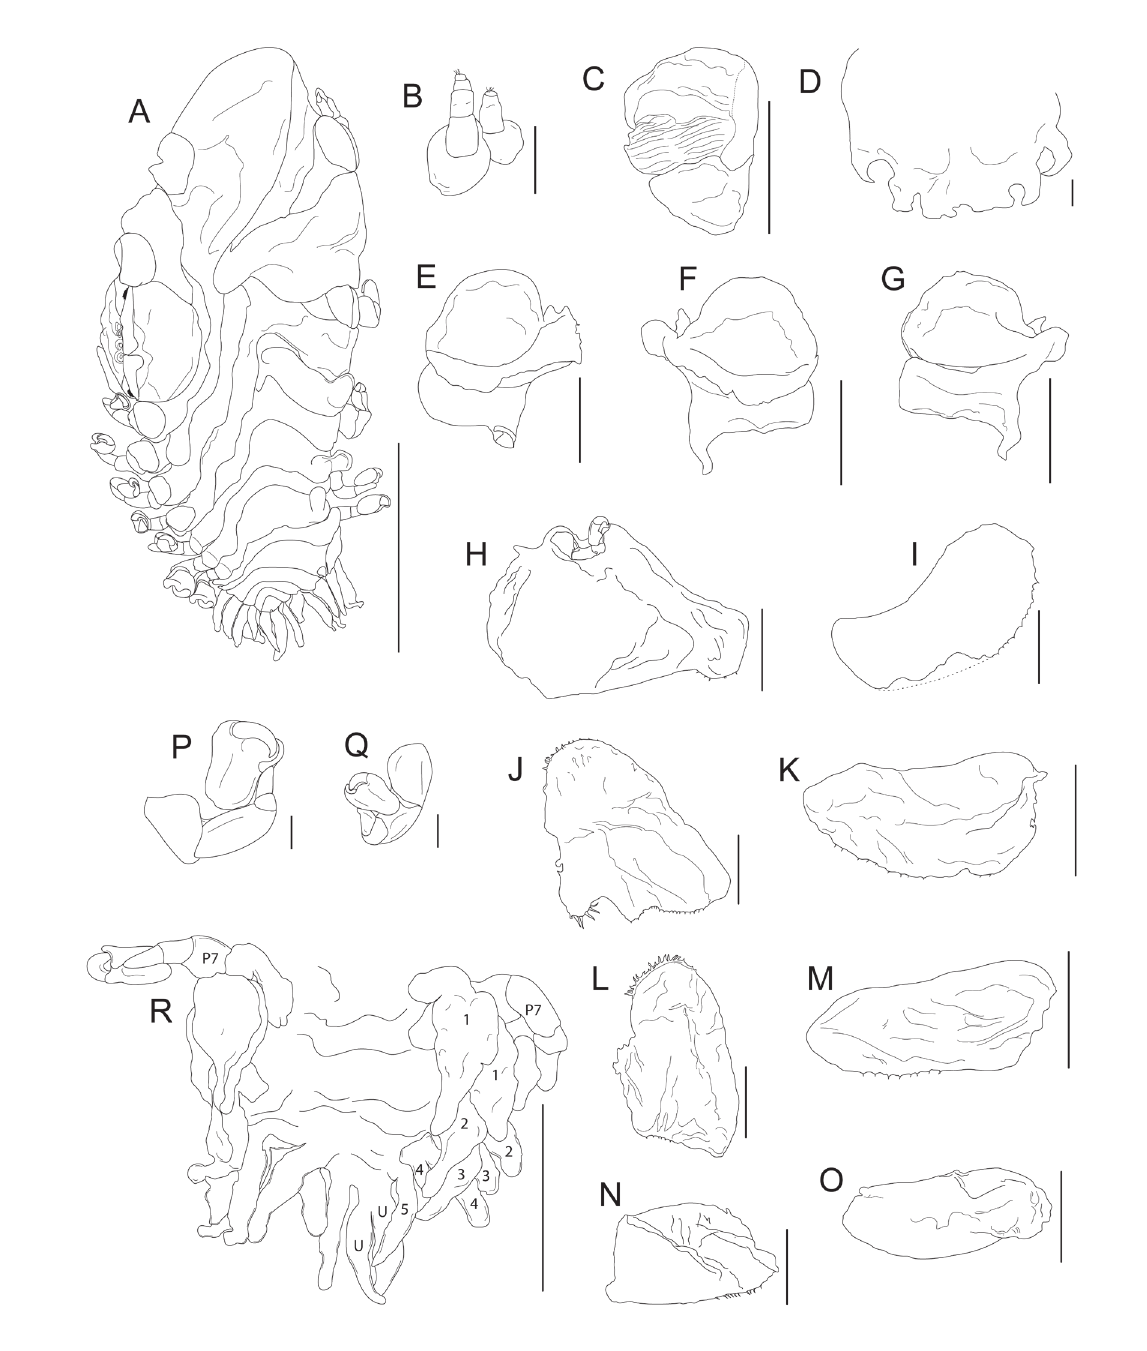
Fig. 7. Asymmetrione tuxtlaensis sp. nov. (CNCR-36493-A). A . Ovigerous ♀, dorsal view, holotype (CNCR-36493-A). B . Antennule and antennae. C . Maxilliped. D . Barbula. E . First oostegite right, internal view. F . First oostegite left, external view. G . Same, internal view. H . Second oostegite right, with second pereopod, external view. I . Second oostegite left, external view. J . Third oostegite right, external view. K . Third oostegite left, external view. L . Fourth oostegite right, external view. M . Fourth oostegite left, external view. N . Fifth oostegite right, external view. O . Fifth oostegite left, external view. P . First pereopod right. Q . First pereopod left. R . Pleon, ventral view. Scale bars: A = 1.0 mm; C, E–N, R = 0.5 mm; B, D, O–Q = 0.1